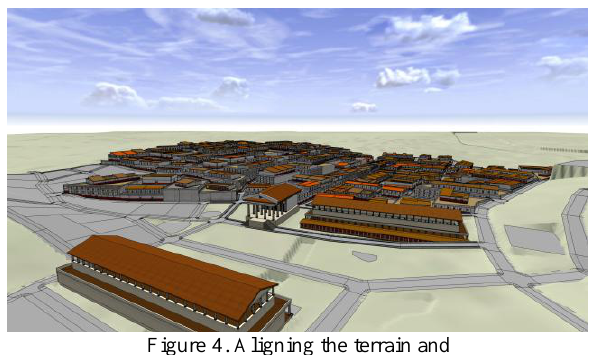
Figure 4. Aligning the terrain and models in CityEngine